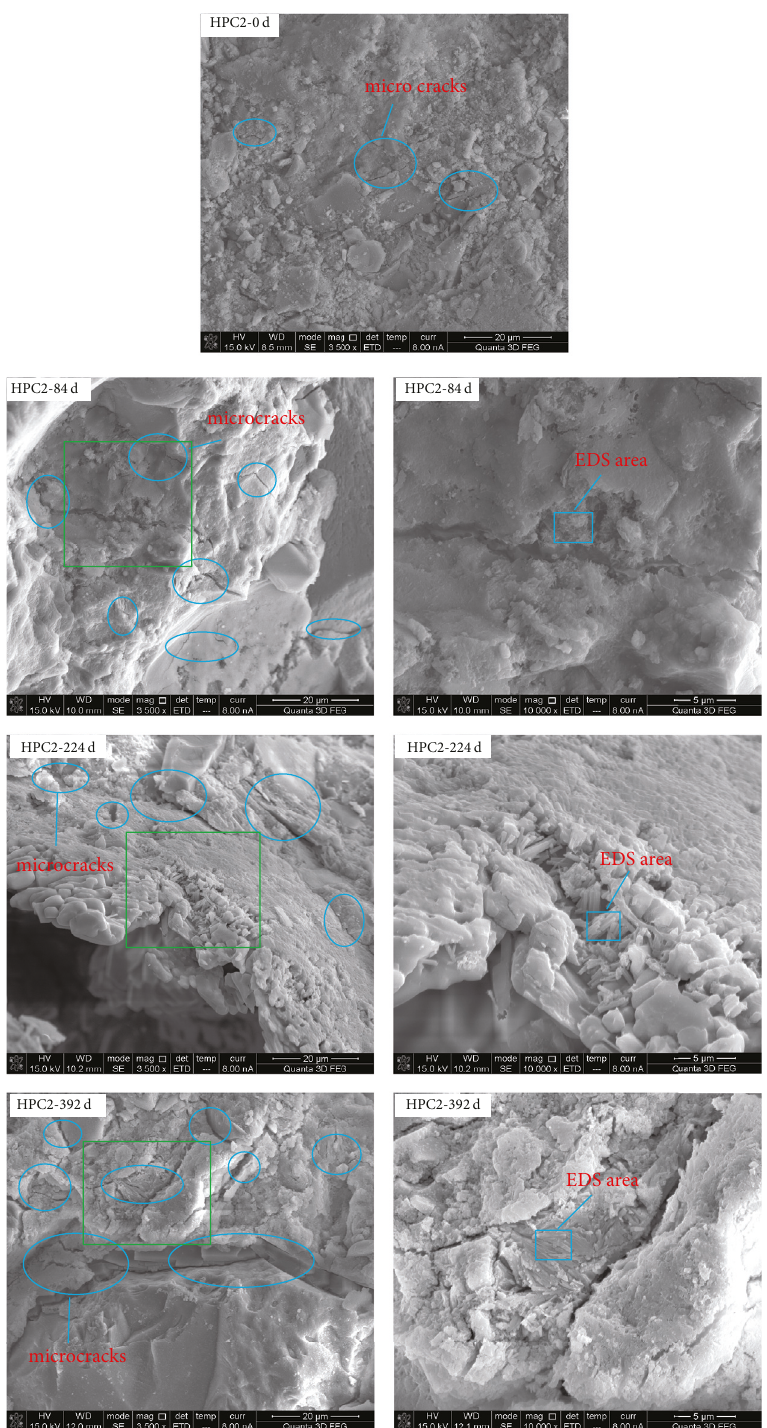
Figure 1: ESEM micrographs of HPC2 before and after exposure to sulfate